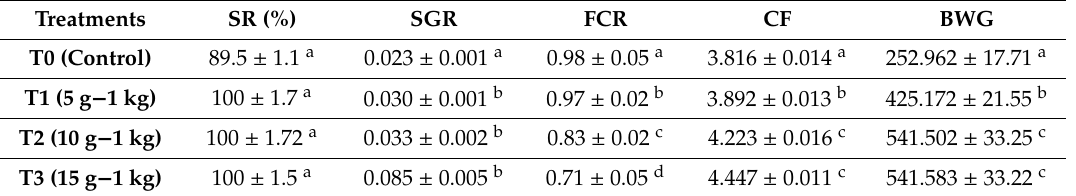
Table 3. Growth indices of Danio rerio feed with di ff erent levels of Vitex agnus-castus for 90 days. Treatments SR (%)